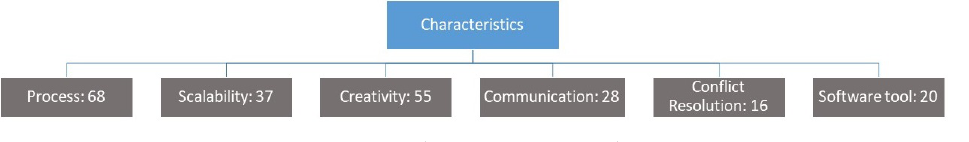
Figure 3. Characteristics: